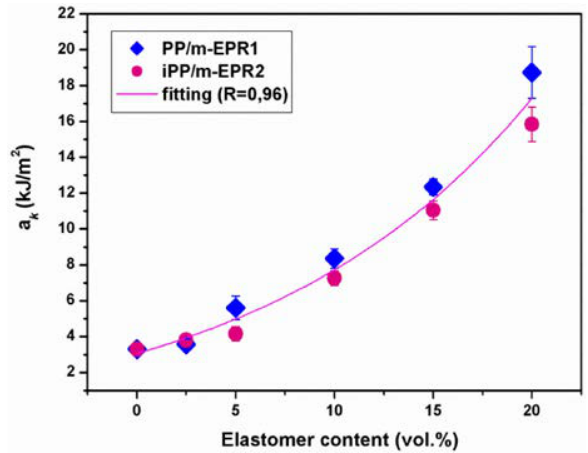
Figure 7. Notched impact strength of the iPP/m-EPR blends in de- pendence on volume content of added elastomers